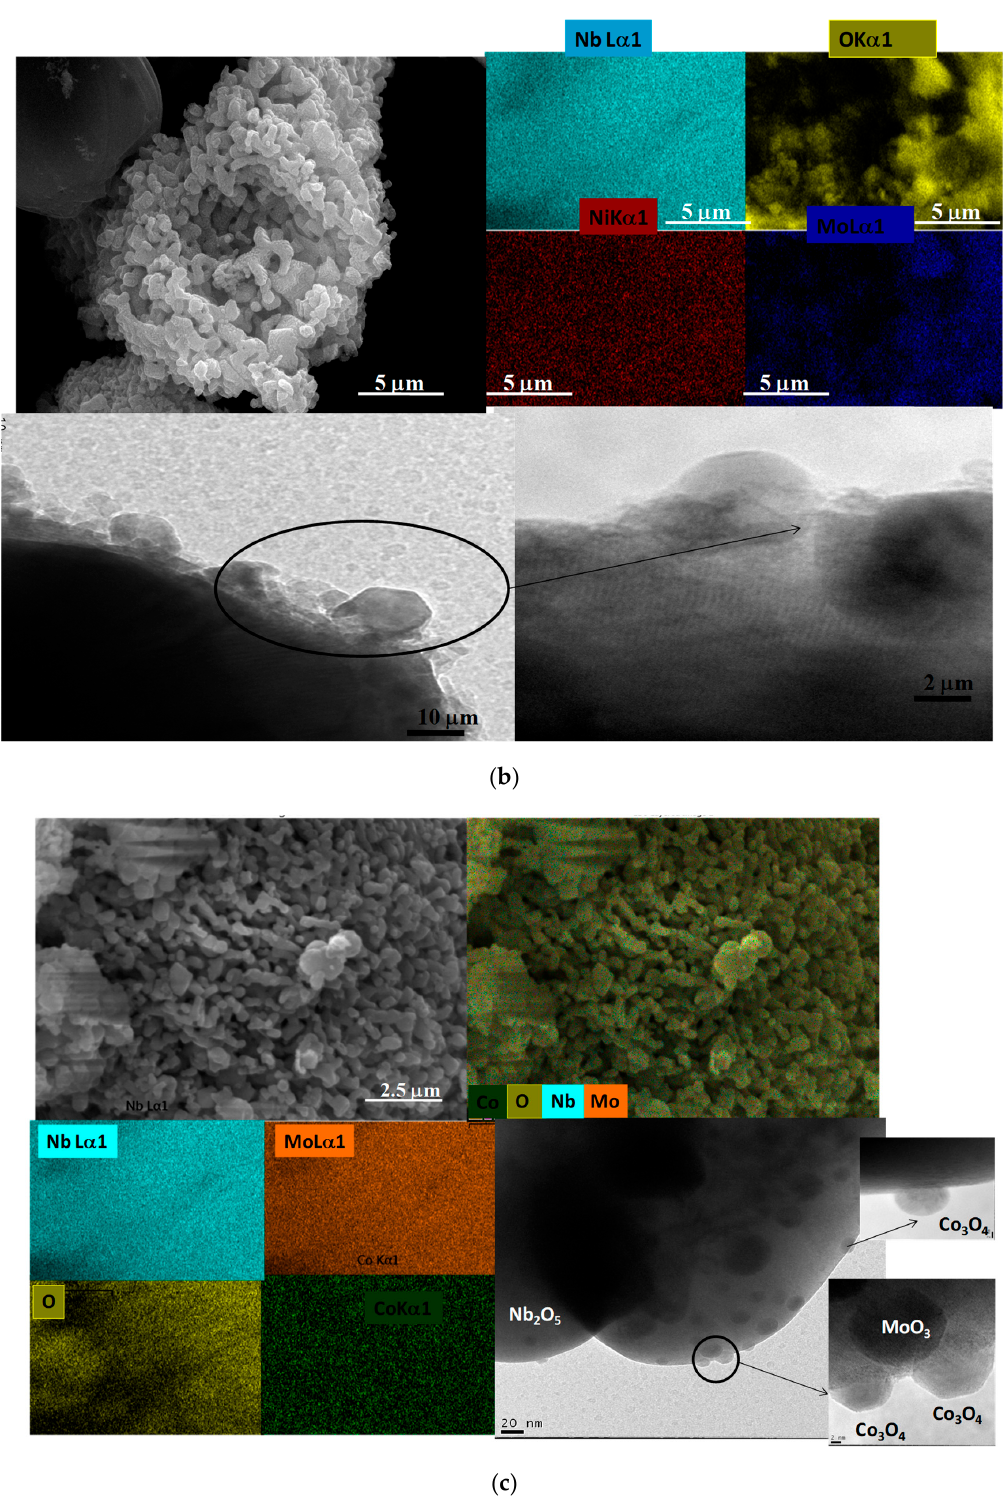
Figure 4. SEM-EDS and HRTEM micrographs of the catalysts: ( a ) PtMo/Nb 2 O 5 , ( b ) NiMo/Nb 2 O 5 and ( c ) CoMo/Nb 2 O 5.